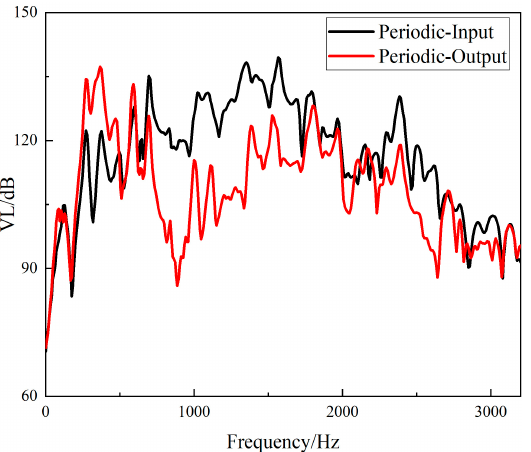
Figure 19. Frequency domain input and output VL Z of the periodic structure support.